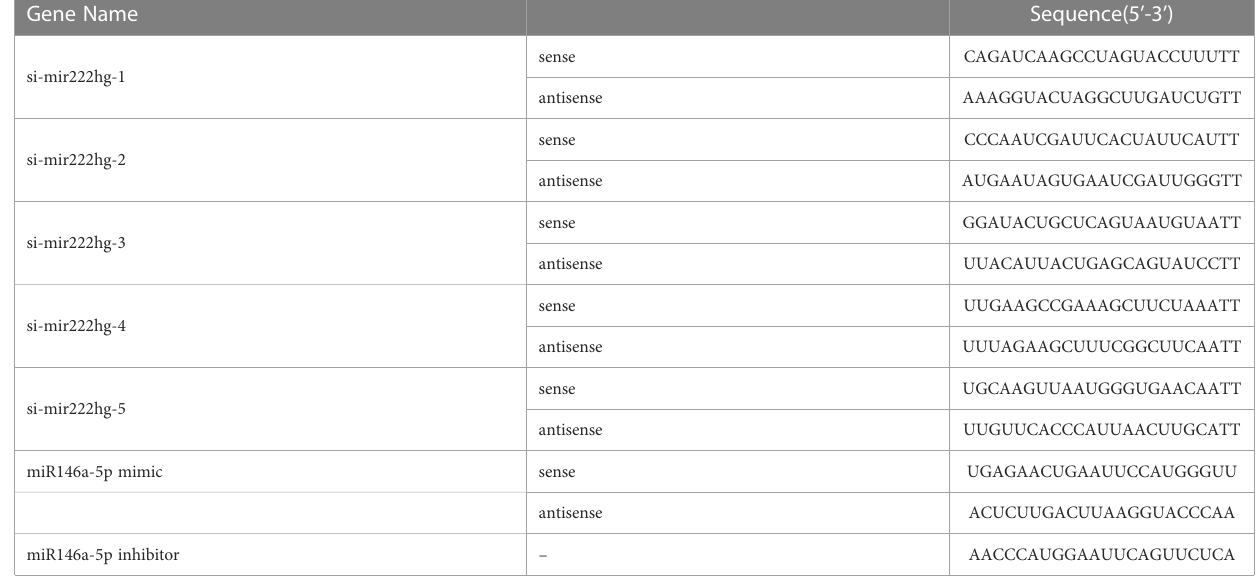
TABLE 2 List of oligonucleotide sequences used for